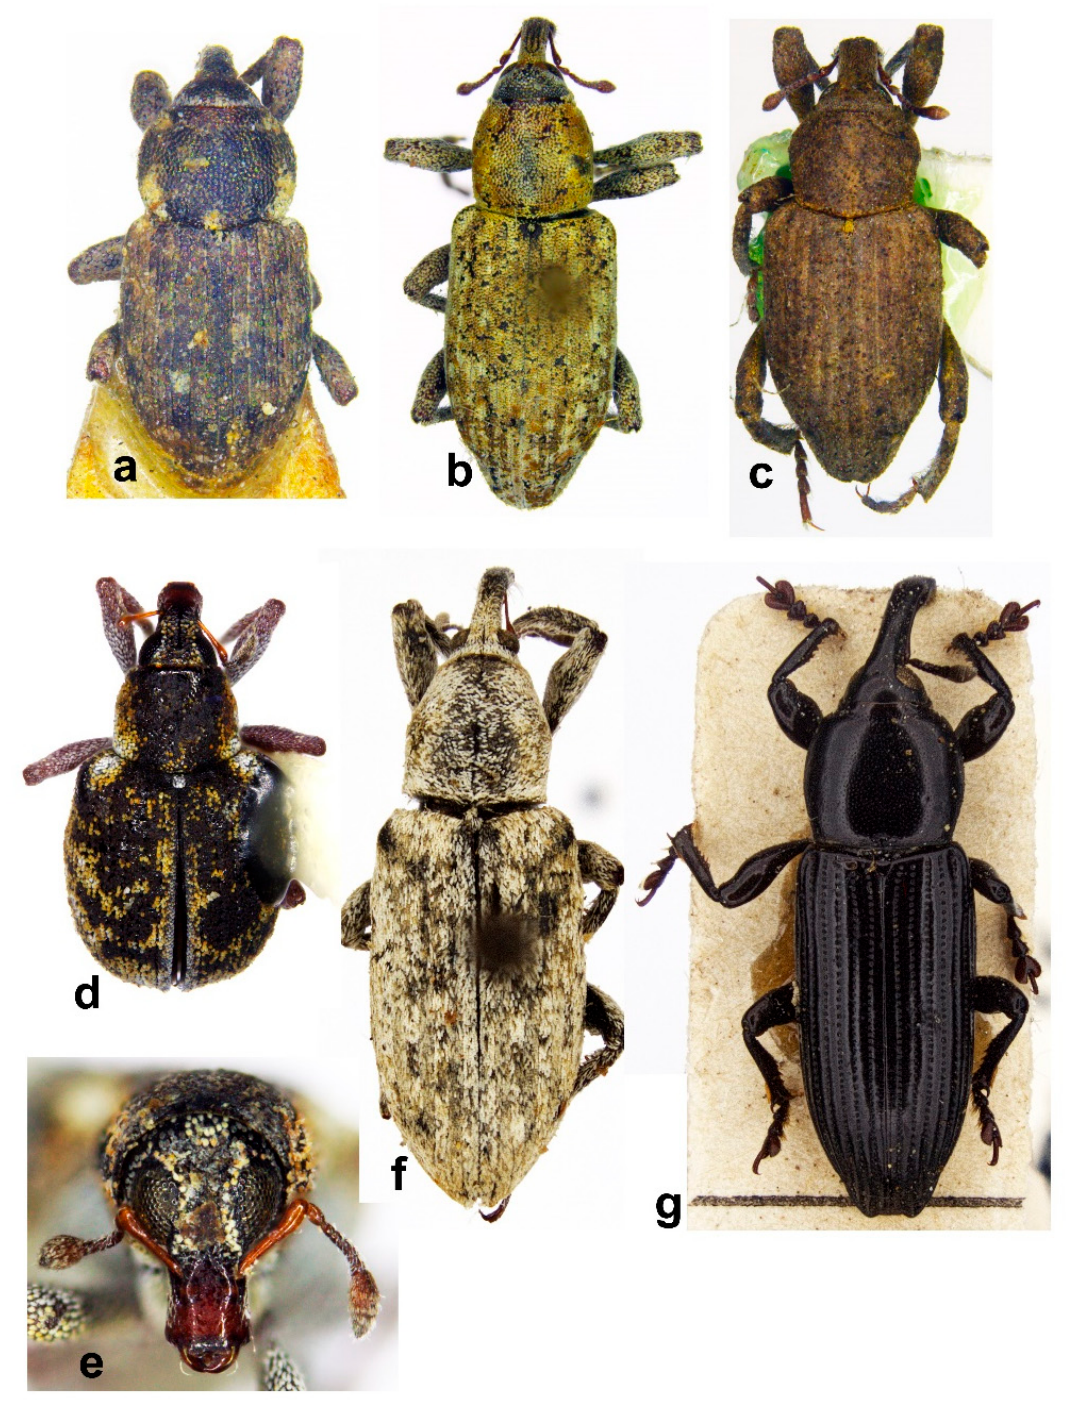
Figure 10. Habitus in dorsal view of ( a ) Echinocnemus reitteri , female; ( b ) Icaris sparganii , male; ( c ) Picia syriaca , male; ( d ) Stenopelmus rufinasus , female; ( e ) S. rufinasus , head, female; ( f ) Arthrostenus fullo , male; ( g ) Aorus anthracinus , male (not on the same scale).